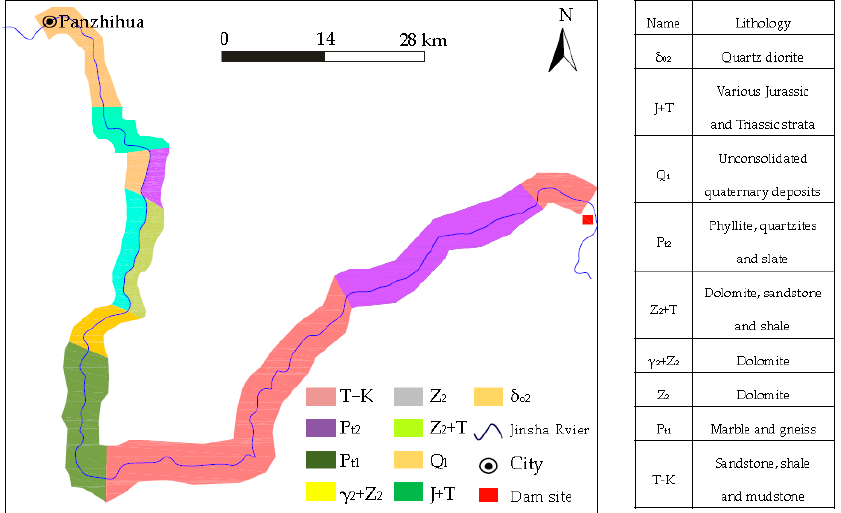
Figure 3. Lithology in the study area [31].